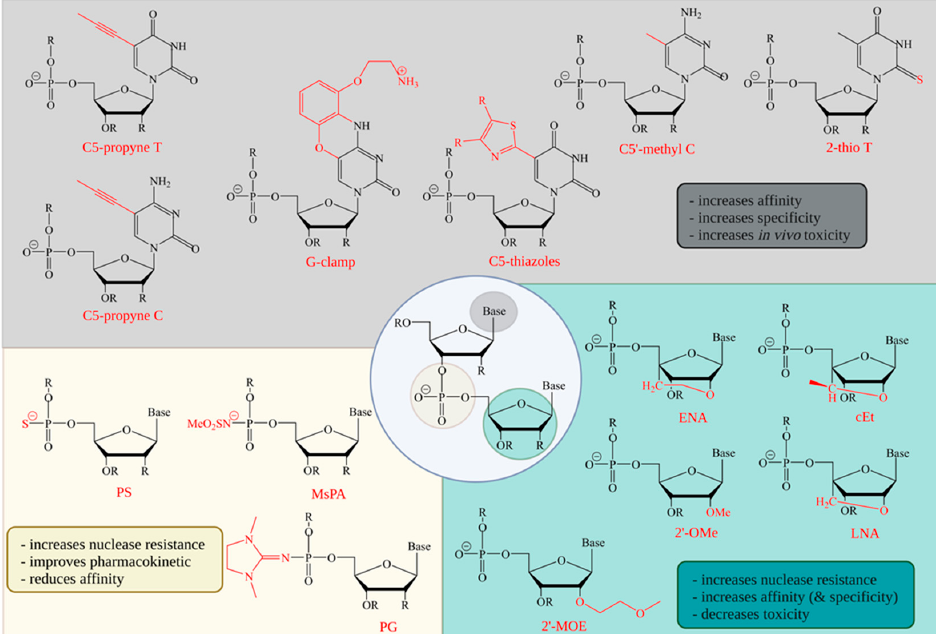
Figure 2. Common ASO nucleotide modifications. ASOs can be optimized at different positions of the nucleotide. Modifications at the phosphate (yellow) reduce affinity, but have positive effects on immunoreactivity and nuclease resistance and thus, also on longevity. Sugar modifications (turquoise) can increase nuclease resistance, affinity, and specificity and decrease toxicity. Disadvantageously, 2 ′ O modifications cause the loss of deoxyribose character and cannot be recognized by RNase H. Therefore, these modifications cannot be implemented in the DNA gap region of gapmer ASOs. Base modifications (gray) may have the greatest potential for increasing the specificity of individual bases, but are also associated with an increased toxicity in vivo. cET = constrained ethylbridged nucleic acid; ENA = 2 ′ O,4 ′ -C-ethylene bridged nucleic acid; LNA = locked nucleic acid; MsPA = mesyl phosphoramidate; PG = phosphoryl guanidine; PS = phosphorothioate; 2 ′ -MOE = 2 ′ - O -methoxyethyl; 2 ′ -OMe = 2 ′ - O -methyl. RNase H interacts with the DNA:RNA junction at three consecutive nucleotides.